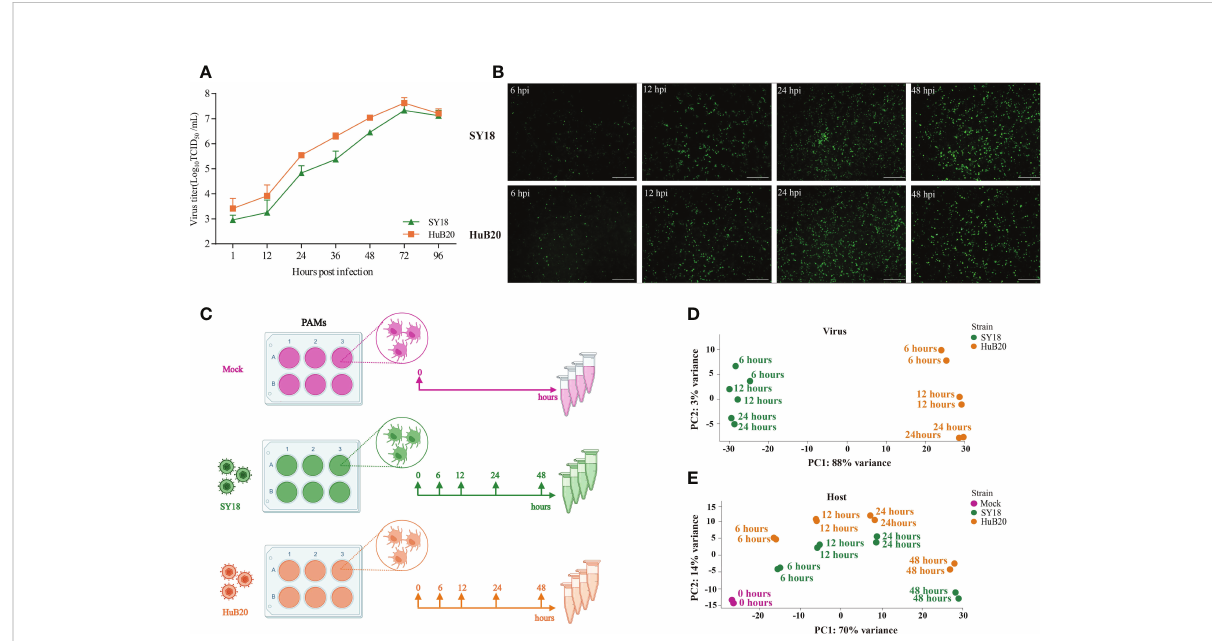
FIGURE 1 RNA-seq analysis of ASFV strains-infected PAMs. (A, B) Identi fi cation of ASFV infection. Viral titers in the supernatants were determined by TCID 50 (A) , and immuno fl uorescence analysis of ASFV viral protein p72 in PAMs infected with ASFV strain SY18 or HuB20 (MOI=0.01) (B) . (C) The work fl ow represents the process of sample collection in this study. PAMs were mock-infected or infected with ASFV strain SY18 or HuB20 (MOI= 3), followed by sample collection at 6, 12, 24 and 48 hpi. Total RNA was extracted and polyA enriched RNA sequencing was performed. The principal component of each sample was analyzed considering the virus genes (D) or host genes (E) expression in the corresponding sample. Samples corresponding to each experimental group were plotted on the fi rst two principal